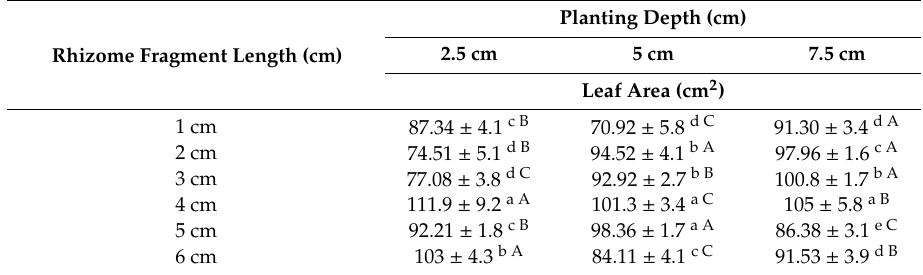
Planting Depth (cm) 2.5